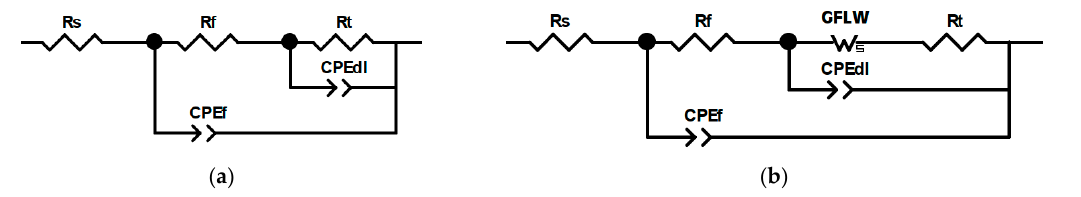
Figure 8. Equivalent circuits (EC) with two ( a ) or three ( b ) time constants used to fit the experimental Electrochemical Impedance Spectroscopy (EIS) spectra on bronze, protected by PropS-SH coatings non- containing or containing CeO 2 , La 2 O 3 , and FA in AR × 10 at 30 °C.